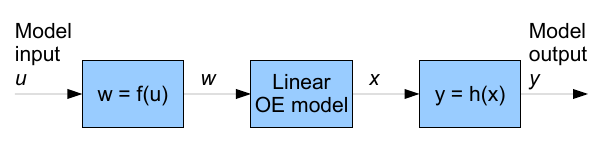
Figure 10: The Hammerstein-Wiener model structure as defined in the MATLAB System Identi- fication Toolbox. The model structure has no noise